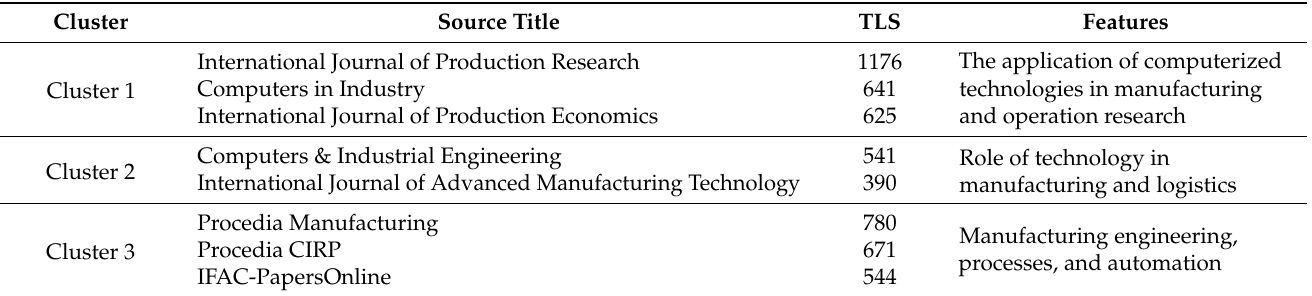
Table 3. Co-citation clusters of smart logistics in Industry